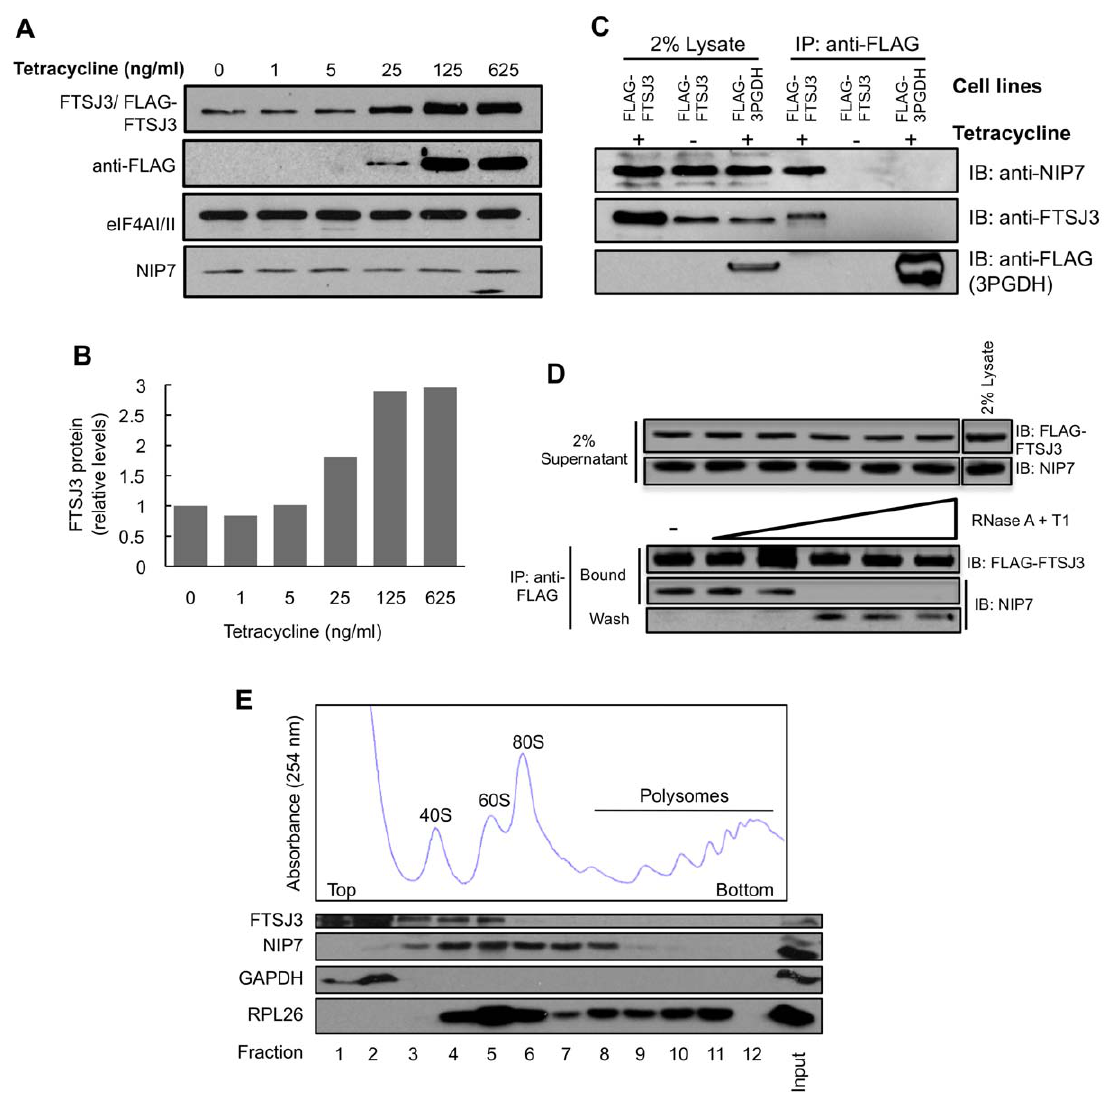
Figure 2. NIP7 associates with FTSJ3 in vivo in an RNA-dependent manner. ( A ) Analysis by western blot of FLAG-FTSJ3 induction in stably transfected HEK293 Flp-In T-Rex cells with increasing concentrations of tetracycline. Both endogenous and recombinant FLAG-FTSJ3 were detected by using antibody specific to FTSJ3. FLAG-FTSJ3 expression was confirmed by using antibody against the FLAG peptide. eIF4AI/II was used as a gel loading control. NIP7 levels are not affected by over-expression of FLAG-FTSJ3. ( B ) FTSJ3 relative levels as determined by band quantification using ImageJ software and normalized to eIF4AI/II. ( C ) Coimmunoprecipitation of NIP7 with FLAG-FTSJ3. FLAG-tagged FTSJ3 and 3PGDH were immunoprecipitated from extracts of stably transfected HEK293 Flp-In T-Rex cell lines using anti-FLAG (IP) followed by immunoblotting (IB) with anti- NIP7, anti-FTSJ3 and anti-FLAG. Parallel controls were performed using cells without induction and with cells stably transfected with FLAG-3PGDH. NIP7 is detected in the immunoprecitipation with FLAG-FTSJ3 (panel IP:anti-FLAG, lane + tetracycline) ( D ) FLAG-FTSJ3 was immunoprecipitated with anti-FLAG from cell extracts of stably transfected HEK293 Flp-In T-Rex treated with increasing concentrations of the RNases A and T1 and immunoblotted with antibodies for NIP7 and FTSJ3. RNase treatment abolishes NIP7 coimmunoprecipitation with FLAG-FTSJ3. ( E ) Analysis of FTSJ3 sedimentation. Cell extracts of HEK293 Flp-In T-Rex cells were fractionated by sucrose density gradient centrifugation and the fractions analyzed by immunoblotting using antibodies for the indicated proteins. FTSJ3 sedimentation overlaps with NIP7 in the range of the 40S–60S ribosome subunits. GAPDH was used as reference for soluble proteins and RPL26 as reference for 60S, 80S and polysome sedimentation.